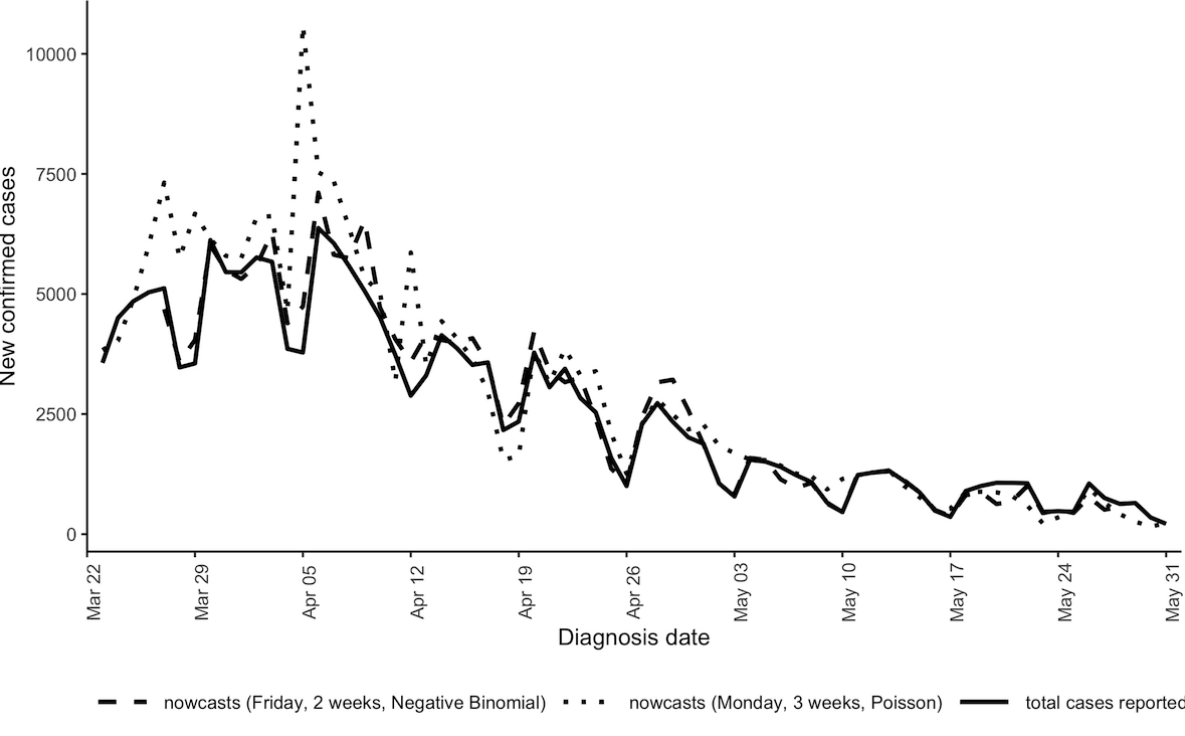
Figure 2. Comparison of 7-day hindcasts conducted on Fridays with a 2-week window and negative binomial distribution, and 7-day hindcasts conducted on Mondays with a 3-week window and Poisson distribution. Total cases reported as of June 30, 2020, are shown with a black